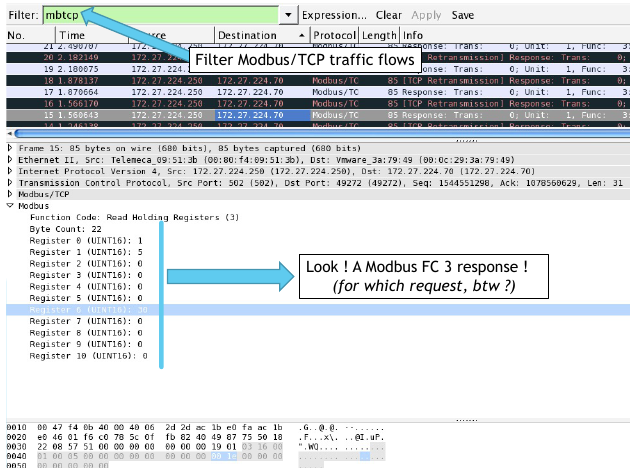
Figure 22. Trace analysis using